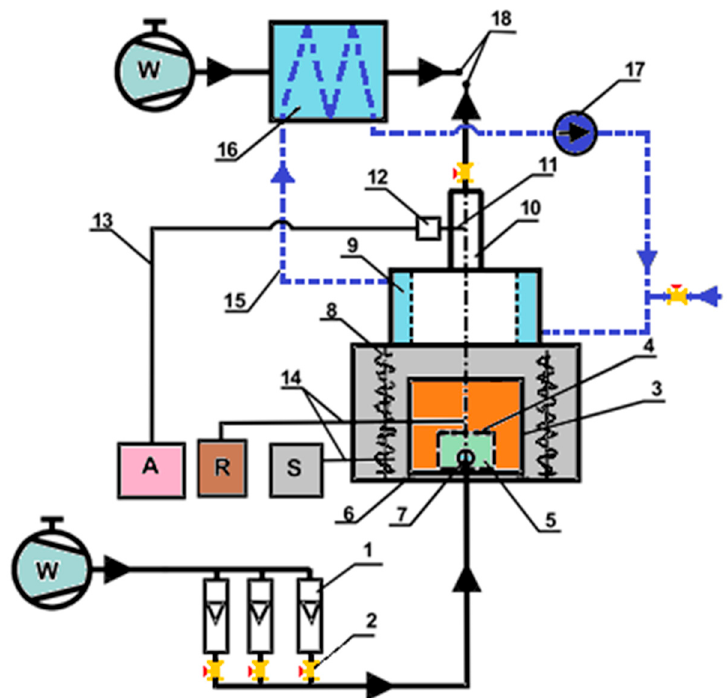
Figure 1. Test stand diagram [38]: A-flue gas analyzer, S-furnace control system, R-recorder, W-ventilator, 1-rotameter, 2-valve, 3-reciprocal bed with a grate, 4-grate, 5-plenum system (ash pit), 6-rail, 7-air nozzle, 8-heating element (electrical), 9-water jacket, 10-stack, 11-measuring probe, 12-probe head, 13-heated hose, 14-thermo elements with compensating cables, 15-cooling water circuit, 16-water/air heat exchanger (cooler), 17-circulation pump, 18 – ambience.